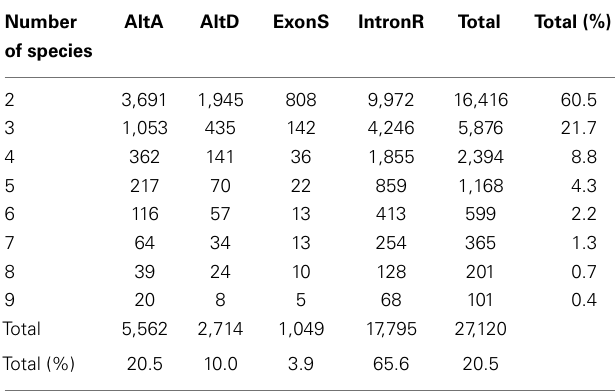
Table 4 | ConservedAS events across angiosperms at gene family level